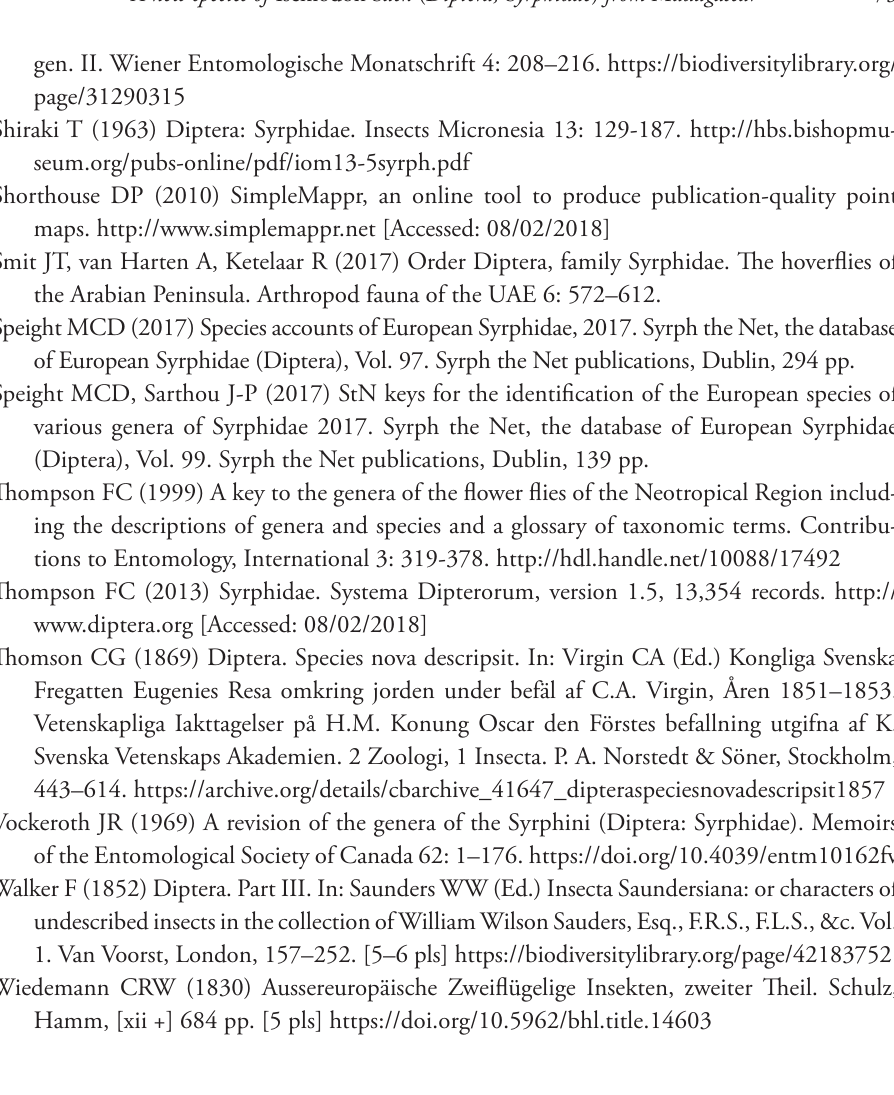
Table S1. Localities for the specimens of Ischiodon astales Mengual, sp. n. (Geo- graphical